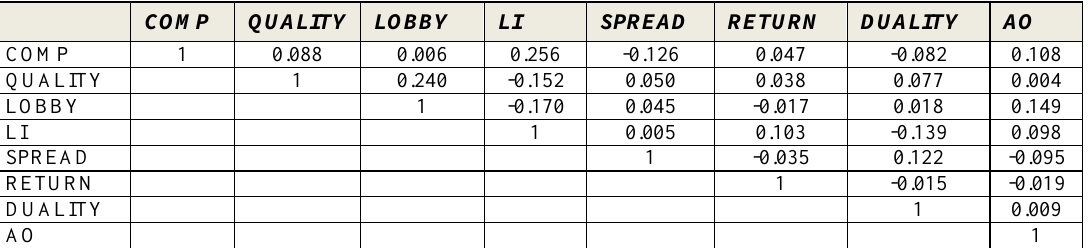
Table 4. Correlation coefficients of variables